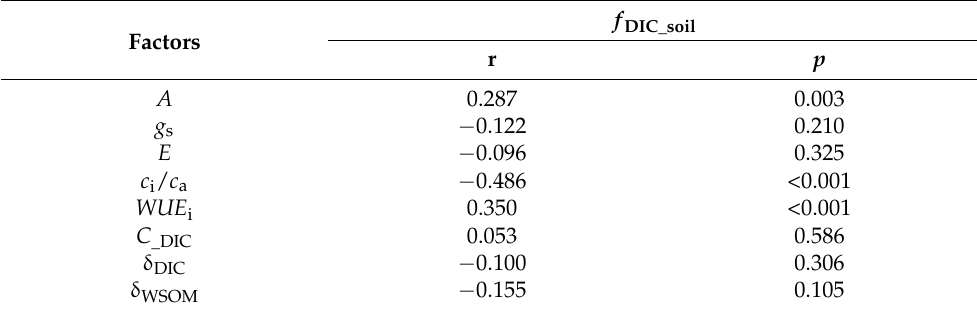
Table 3. Relationships between physiological or environmental factors and f DIC_soil analyzed by Pearson’s correlation. N = 108.